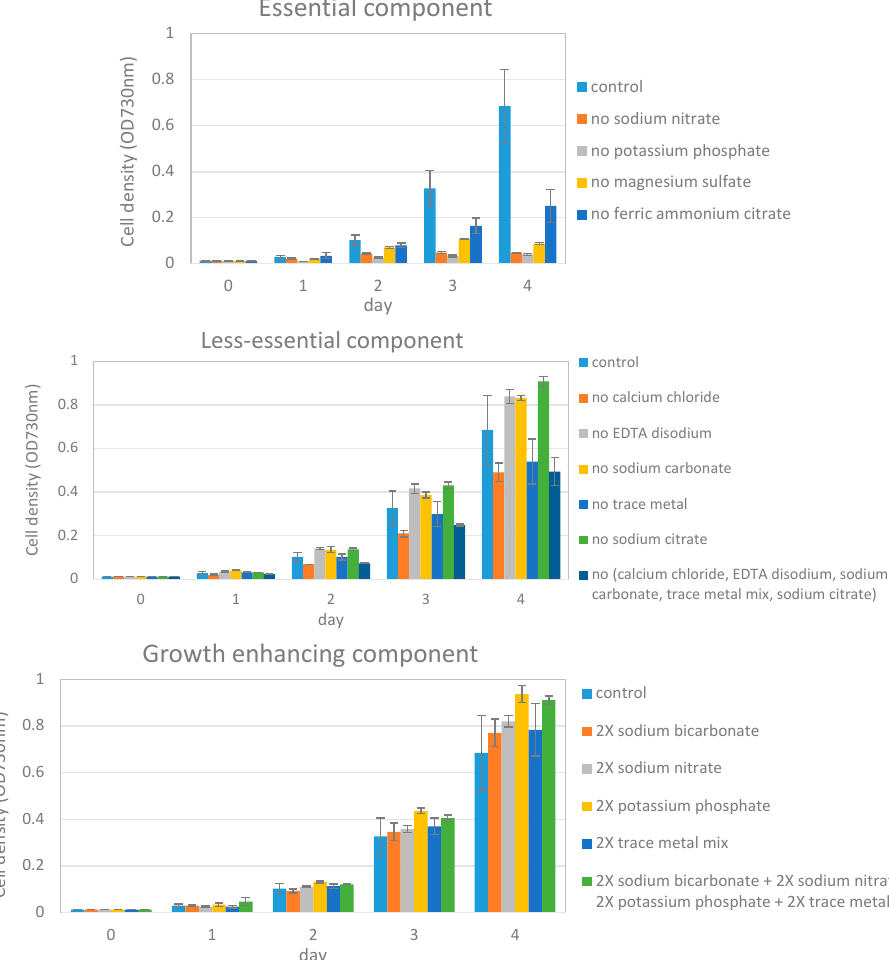
Figure 4. Verification of significant findings from the microfluidic experiments in bench-scale flasks. The results were grouped into three categories, essential, less essential, and growth enhancing depending on if their supplementation was necessary to maintain normal cell growth in flasks compared to the control (grown under regular BG-11 medium). For all the tests shown here, the BG-11 medium was modified according to the figure legends shown.